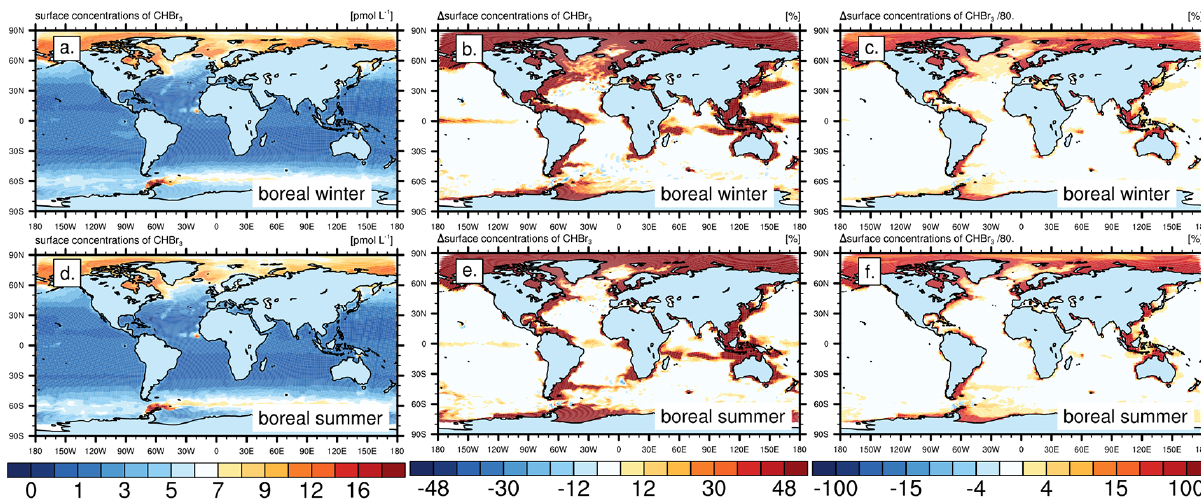
Figure 4. Mean surface bromoform concentrations (pmolL − 1 ) in experiment Equi in boreal winter (a) and boreal summer (d) and the − Equi percentage difference (e.g. 100 · Coast Equi